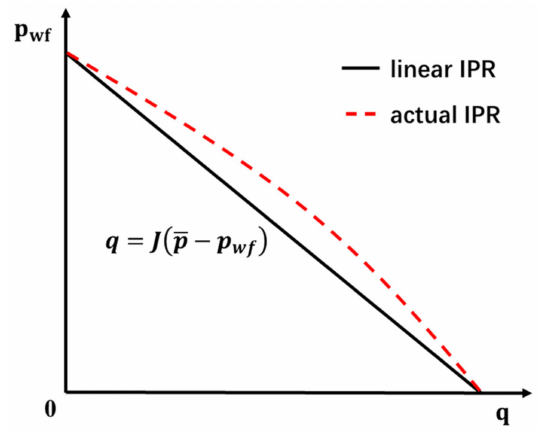
Figure 3. The inflow performance relationship (IPR) curves. The black line is the linear IPR prediction curve, and the red dashed line is the IPR curve of unstable